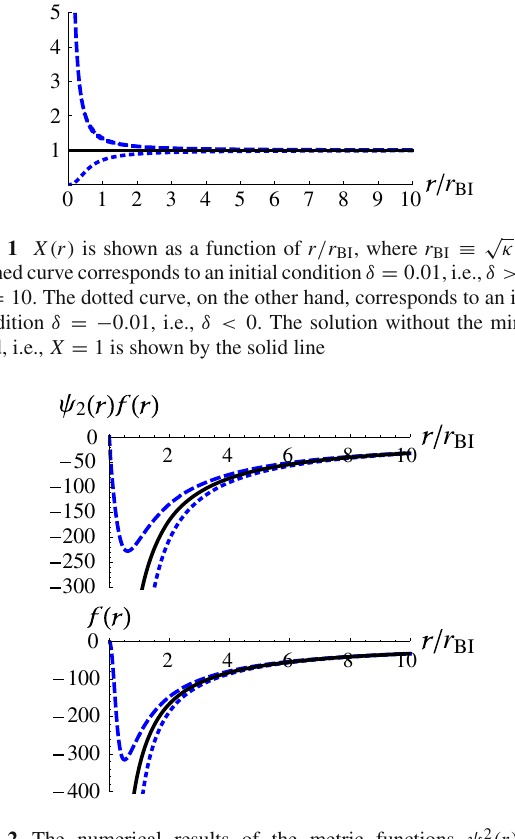
Fig. 2 The numerical results of the metric functions ψ 2 ( r ) f ( r ) (upper) and f ( r ) (lower) are shown as functions of r / r BI . The stan- dard Schwarzschild solution is shown by the solid